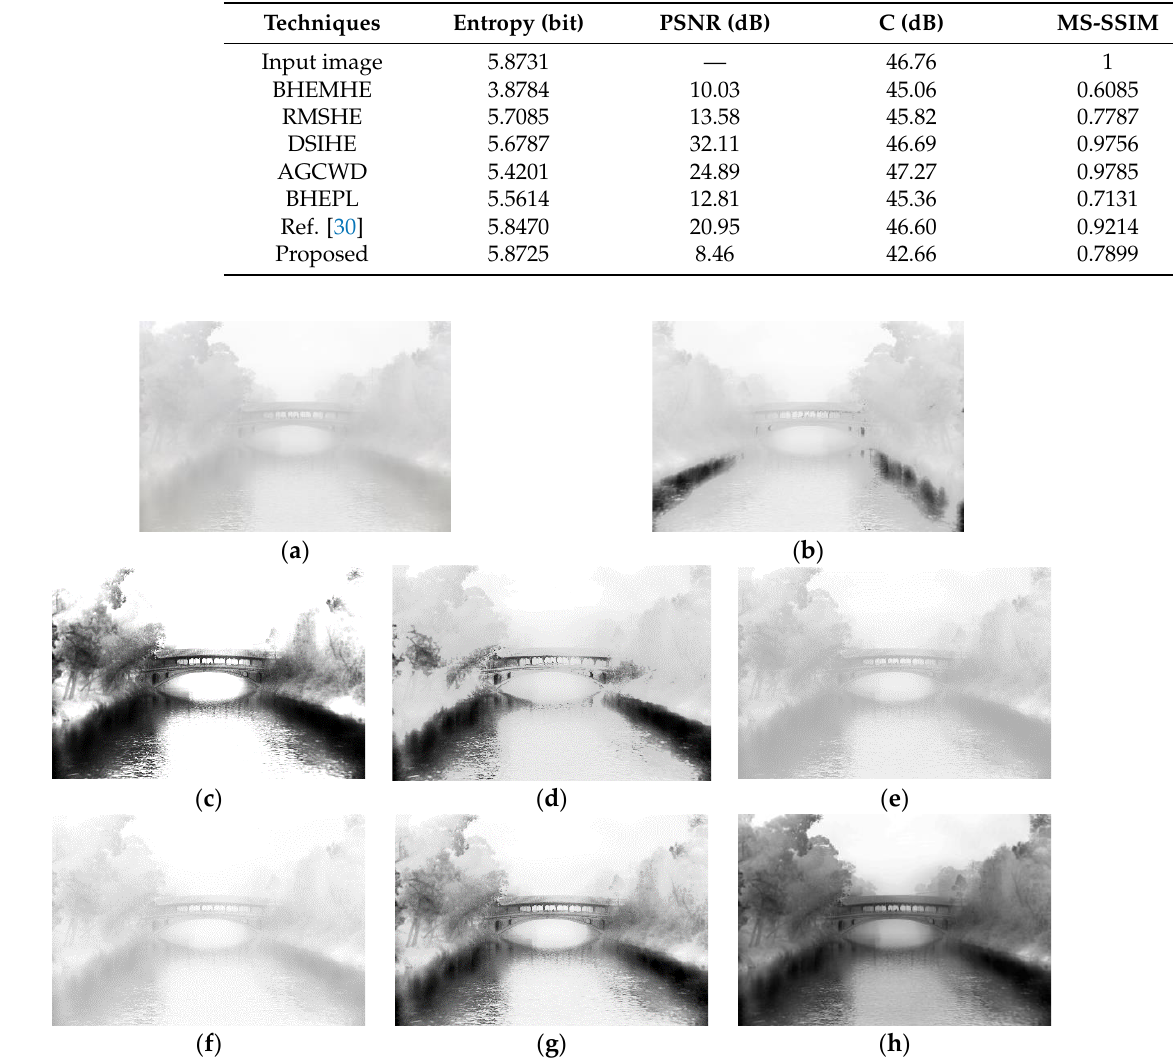
Figure 11. Results of several algorithms for “ bridge ” image enhancement. ( a ) original image, “ bridge ” ; ( b ) Ref. [30]; ( c ) BHEMHE; ( d ) RMSHE; ( e ) DSIHE; ( f ) AGCWD; ( g ) BHEPL; ( h ) proposed algorithm. Table 4. Experimental data for the high-grayscale image “ bridge ” .